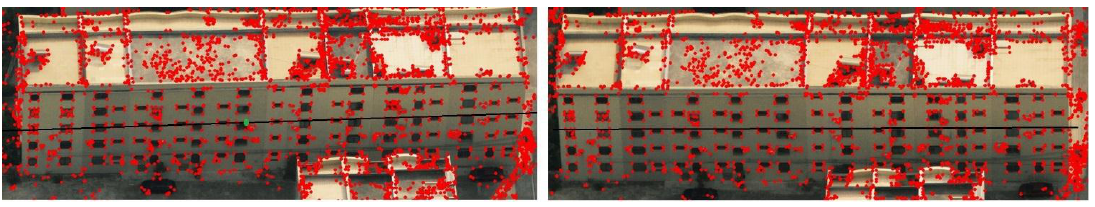
Figure 11. Epipolar-based shi-tomasi point matching. For the corner (green) in reference/left